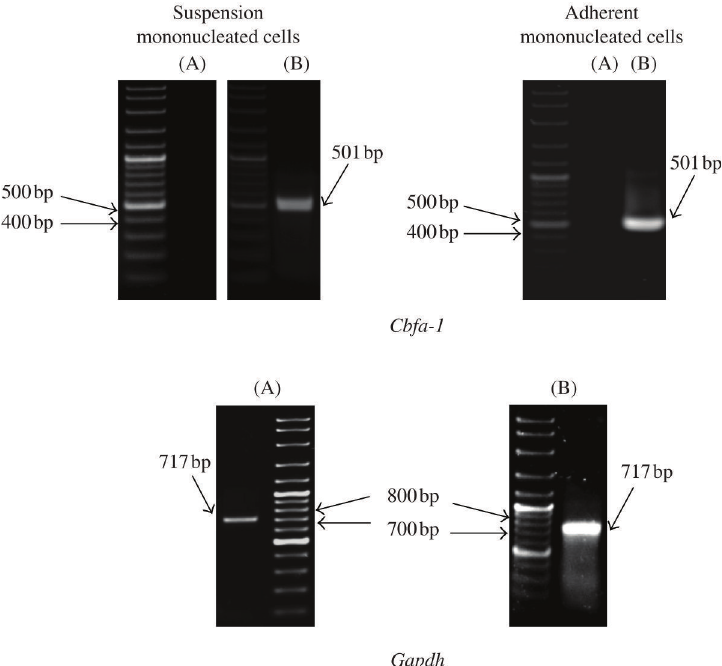
FIGURE 3: Active and inactive osteoblast progenitor markers and housekeeping gene in suspension and adherent mononucleated cells. (A) Cbfa-1 in undifferentiated mononucleated cells. (B) Cbfa-1 in mononu- cleated cells after 3 days in osteoblast differentiation medium. Gapdh is represented in suspension and adherent undifferentiated mononucleated cells (Left) and mononucleated cells after 3 days in osteoblast differentiation medium (Right). Cbfa-1 was not active in mononucleated cells but was active after 3 days in osteoblast differentiation medium. The positive control, Gapdh , was active before and after differentiation of mononucleated cells into